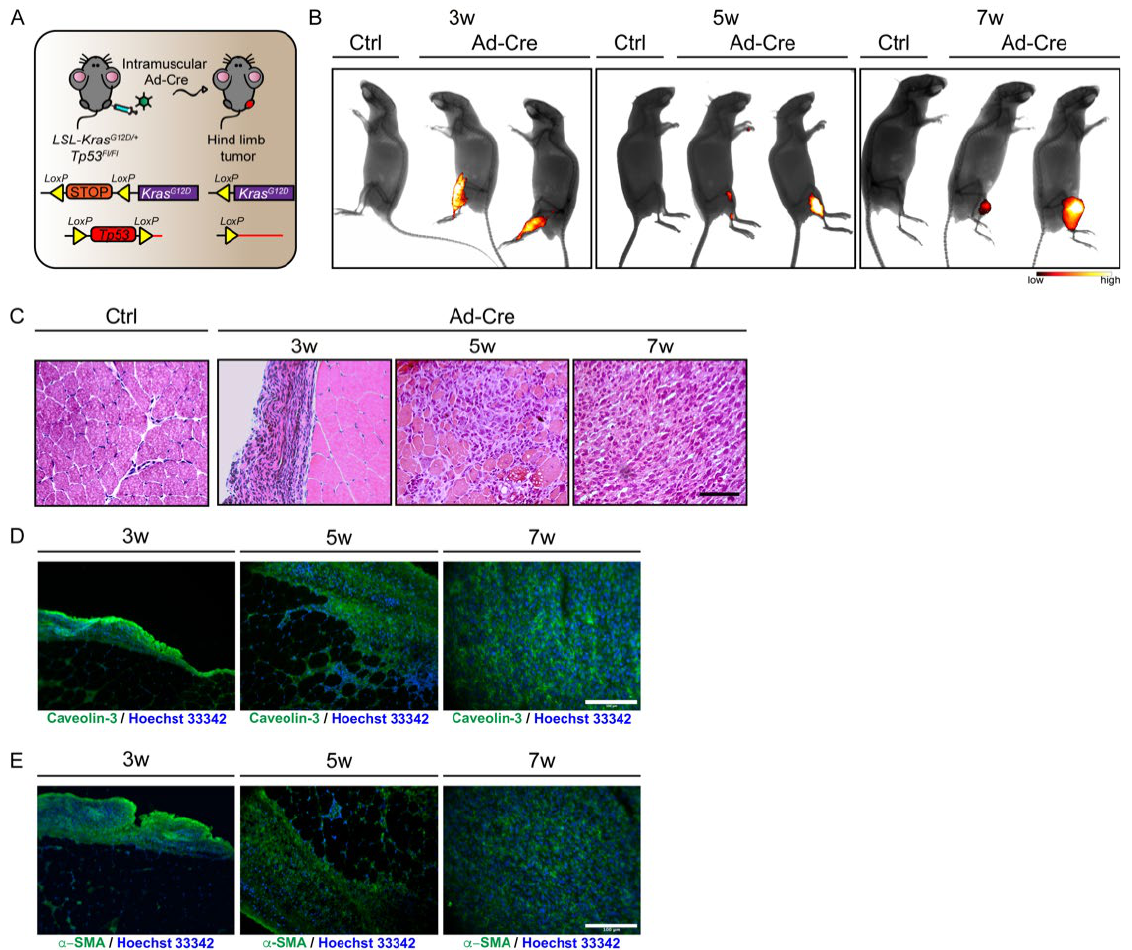
Figure 1. Generation of eRMS tumors in LSL-Kras G12D/+ ;Tp53 Fl/Fl mice. ( A ) Experimental workflow. LSL-Kras G12D/+ ;Tp53 Fl/Fl conditional mice were injected intramuscularly with Ad-Cre in order to induce genetic rearrangements, the constitutive activation of Kras and the inactivation of Tp53, which lead to eRMS tumor masses in a spatially and temporally controlled manner. ( B ) LSL-Kras G12D/+ ;Tp53 Fl/Fl conditional mice were injected with Ad-Cre and Ctrl vector. Tumor growth was assessed at three, five and seven weeks after Ad-Cre infection through FMT performed by intravitreal administration of the fluorescent probe (ProSense 680). This probe was activated by tumor cathepsin proteases to yield a fluorescence signal (black: low cathepsin activity; white: high cathepsin activity). ( C ) Representative H&E staining on histological sections from Ctrl and Ad-Cre infected muscles at three, five and seven weeks after Ad infection. ( D , E ) Immunofluorescence staining on sections of Ad-Cre infected muscles at three, five and seven weeks after infection. Sections were stained with antibodies raised against Caveolin-3 ( D ) and α -SMA ( E ). Scale bars: 100 µm.